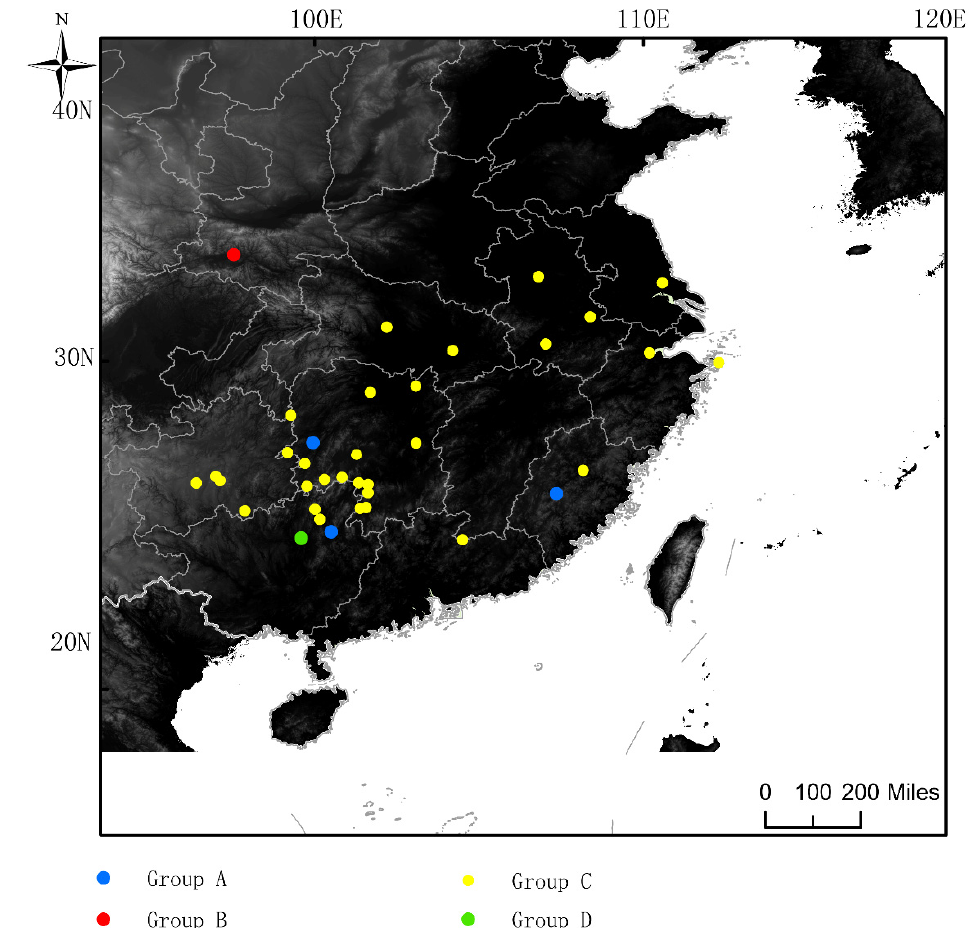
Figure 1. Sampling sites of G. japonicus . Different colors represent different SAMOVA grouping results The blue circles represent the sampling points of Group A, red circles represent the sampling points of Group B, yellow circles represent the sampling points of Group C, green circles represent the sample sampling points of Group D. Group A: Yongan, Fujian, Yangshuo, Guangxi, Huaihua, Hunan; Group B: Yangxian, Shaanxi. Group C: Anhui (Anqing, Lu’an, Wuhu), Fujian Nanping,